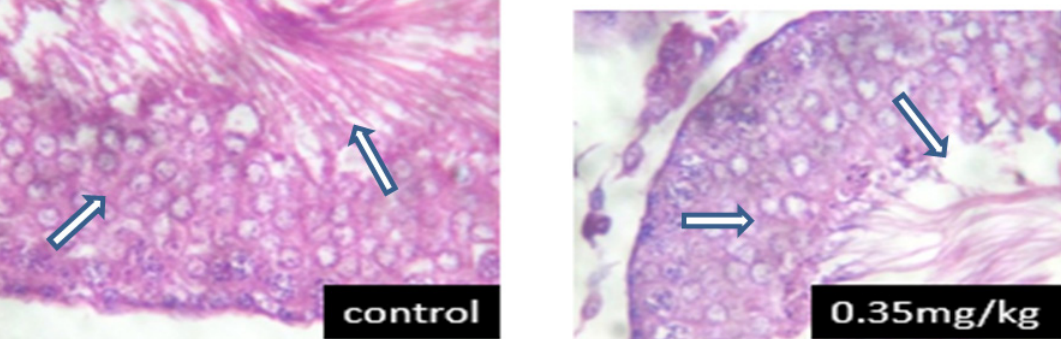
FIGURE 6 – Photomicrograph of the histology of the seminiferous tubules of rats after 8 weeks recovery period. H & E X 400 magnification. The seminiferous tubules appear normal showing spermatogenic cells at different stages of